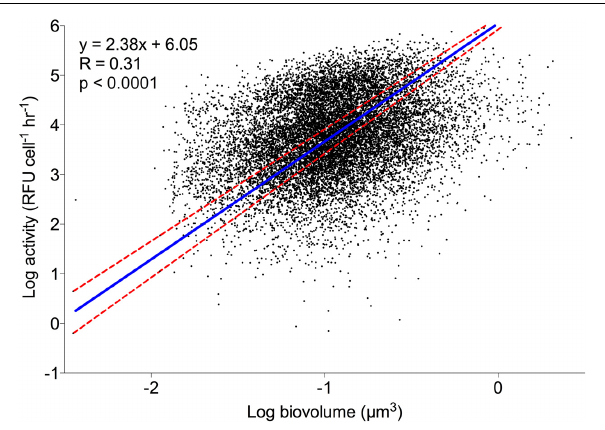
FIGURE 3 | Individual cell HPG signal intensity relative to cell size. A model II regression (blue line) shows log-transformed sum intensity scaled significantly with log-transformed cell volume. Red dashed lines are 95% confidence intervals. n =